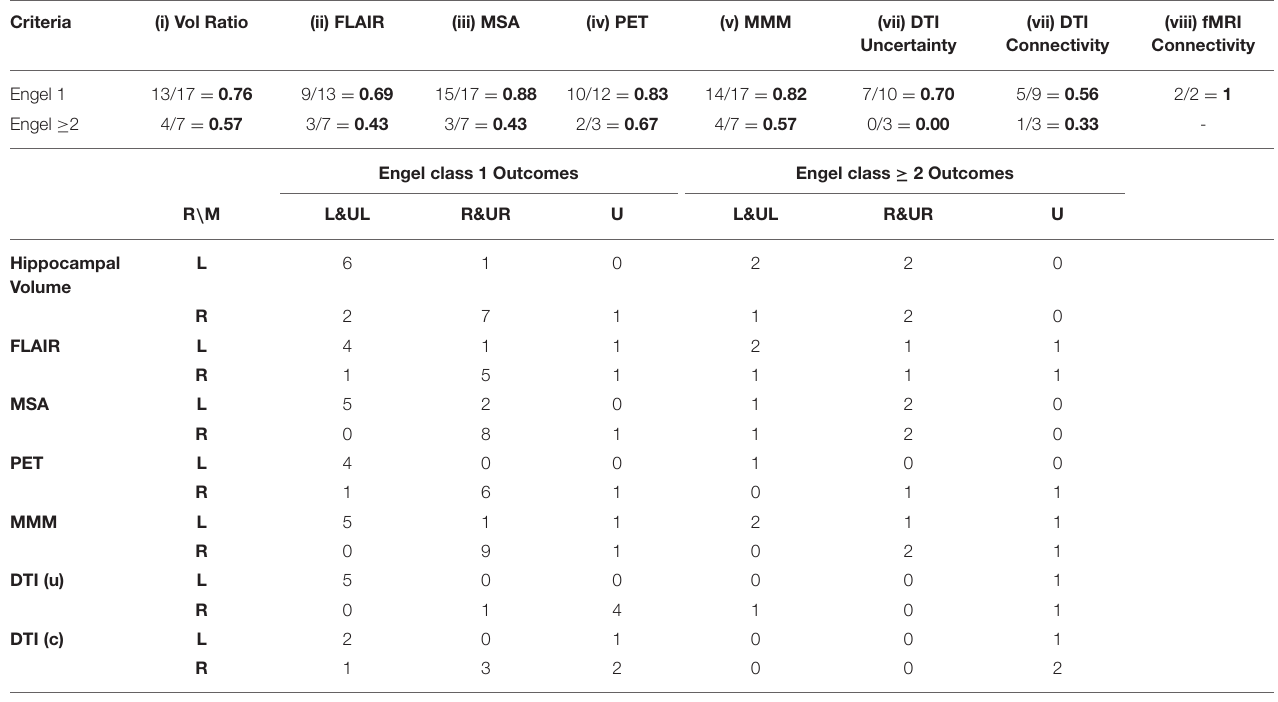
TABLE 3 | Match of predicted values of individual, multistructural and multimodal study metrics with actual outcomes (Engel class 1 vs. Engel class ≥ 2).